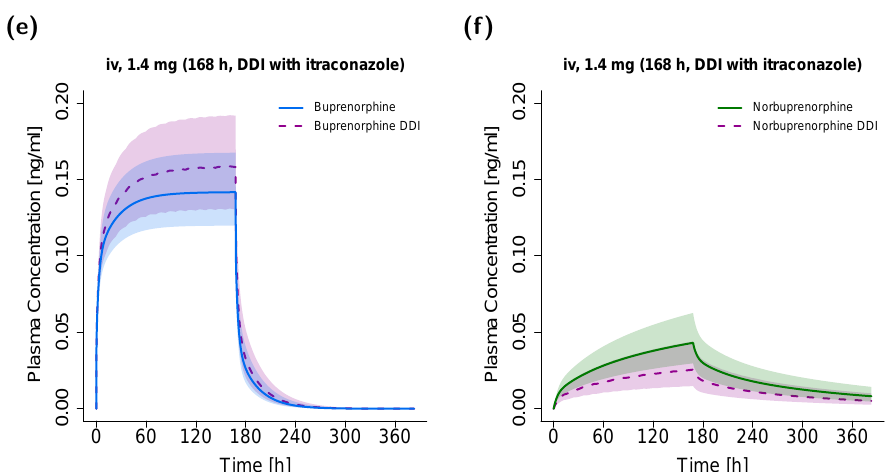
Figure 6. DDI scenarios for buprenorphine (blue, left panel) and norbuprenorphine (green, right panel) with the perpetrator drugs rifampicin (( a , b ), semilogarithmic), clarithromycin (( c , d ), linear) and itraconazole (( e , f ), linear) in adults. Buprenorphine and norbuprenorphine plasma concentrations during concomitant administration of a DDI perpetrator drug are shown in purple. Population simulations (n = 100) are shown as lines with shaded areas. If available, observed data are shown as filled circles ± standard deviation ( a ). References link to a specific observed dataset described in Table 1. Information about dosing regimens as well as observed and predicted AUC ratios for buprenorphine and norbuprenorphine are depicted in Table 3. DDI, drug-drug interaction; iv,